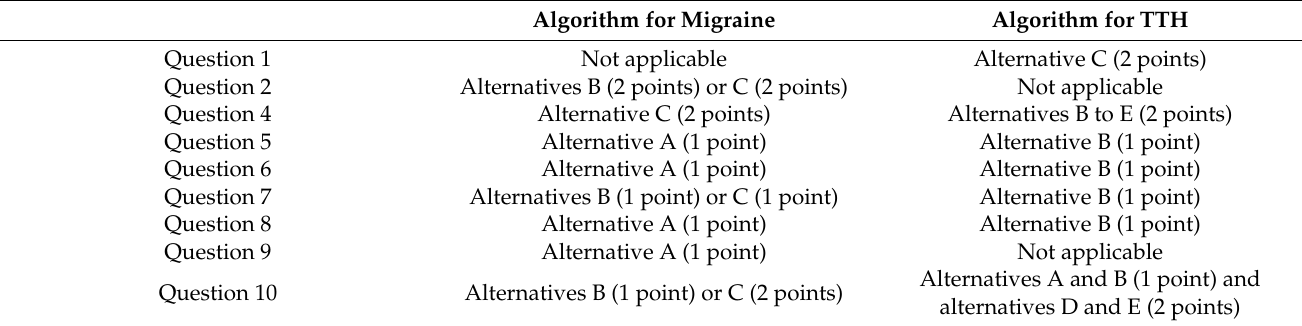
Table 9. The Headache Screening Questionnaire Algorithm for Migraine and Tension-type Headache (TTH). Algorithm for Migraine Algorithm for